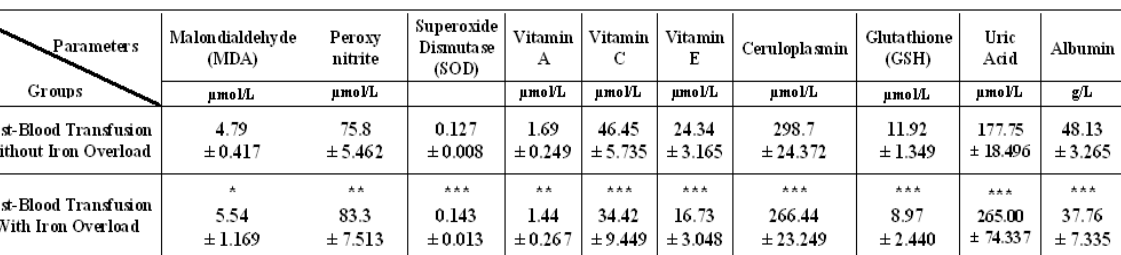
Table 4: Effects of iron overload in thalassemic patients, after blood transfusion, on lipid peroxidation and antioxidant